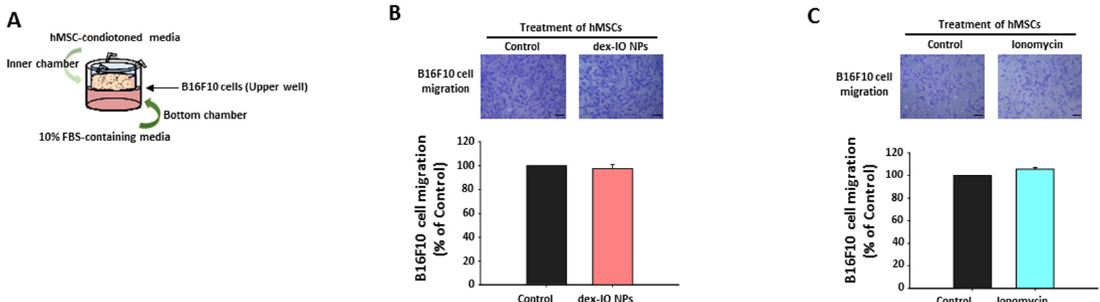
Figure 2. Effects of hMSC-conditioned media in the upper chamber on B16F10 cell migration in the transwell migration assay. ( A ) Schematic illustration of the experimental procedure. hMSCs were first treated without (Control) or with dex-IO NPs for 1 h or ionomycin for 30 min followed by wash, and then conditioned media from hMSCs incubated for 24 h were collected and added to the inner chambers. ( B , C ) Migration of B16F10 cells incubated with hMSC-conditioned media. Top panel: representative images of the migration of B16F10 cells by crystal violet staining. Bottom panel: quantification of the migration of B16F10 cells. Data are presented as the mean ± SEM of three independent experiments. Scale bar: 20 µ